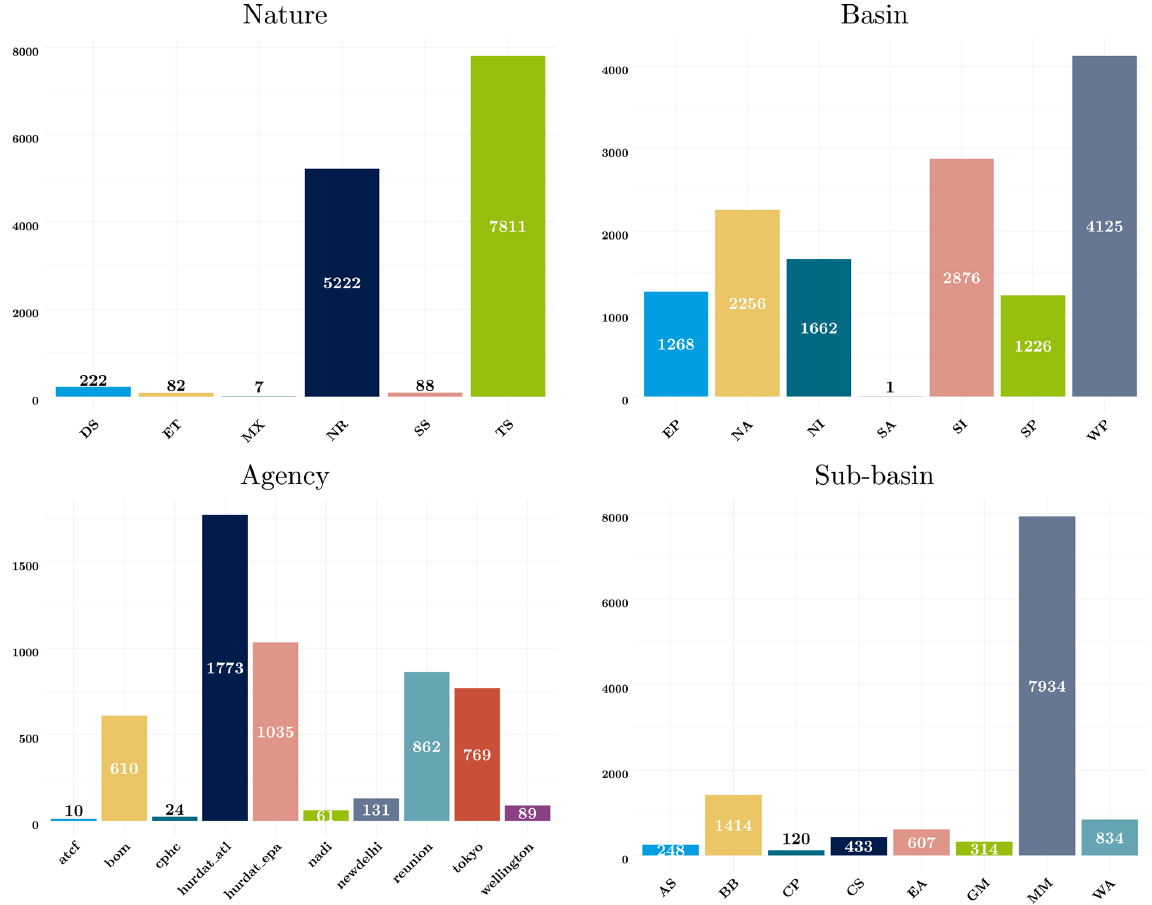
Figure A1. Information in IBTrACS. The cyclones are split by nature (DS: disturbance; TS: tropical; TE: extratropical; ST: subtropical; NR: not reported; MX: mixture or contradicting nature reports from different agencies). We remove extratropical cyclones (75) and disturbance (205). The cyclones are reported in the following basins: eastern Pacific (EP); North America (NA); northern India (NI); South Atlantic (SA); southern India (SI); South Pacific (SP); western Pacific (WP). One can also explore sub-basin decomposition (Eberenz et al., 2021) (MM: missing – no sub-basin for this basin (no sub-basins provided for WP, SI); CS: Caribbean Sea; GM: Gulf of Mexico; CP: central Pacific; BB: Bay of Bengal; AS: Arabian Sea; WA: western Australia; EA: eastern Australia), but we chose to use basins. The different agencies worldwide report central pressure and maximum wind speed but sometimes use sometimes different standards. In particular, the reporting can vary in terms of sustained wind speed. According to the dataset documentation, the North Atlantic – US Miami (NOAA NHC) bureau (hurdat/atcf) gives the 1min winds speed, while Tokyo, i.e., RSMC Tokyo (JMA), provides directly the 10min sustained wind speed. (Similarly, newdelhi corresponding to RSMC New Delhi (IMD) gives the 3min wind speed, reunion RSMC La Reunion (MFLR), the Australian TCWCs (TCWC Perth, Darwin, Brisbane) (BOM), and the RSMC Nadi (FMS); TCWC Wellington (NZMS) provides the 10min sustained wind speed and (CMA) 2min sustained wind.) The lack of reporting standards between agencies is a source of uncertainty in the input